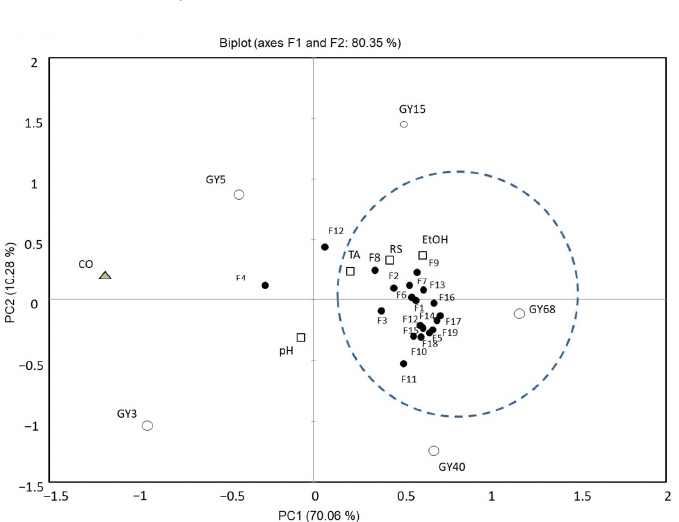
The increment values are calculated by the number of volatile flavor compounds in other samples divided by the number of volatile flavor compounds in a 3-day fermented Gayangju . Different small letters (a–f) indicate significant differences of values between commercial Makgeolli samples and Gayangju